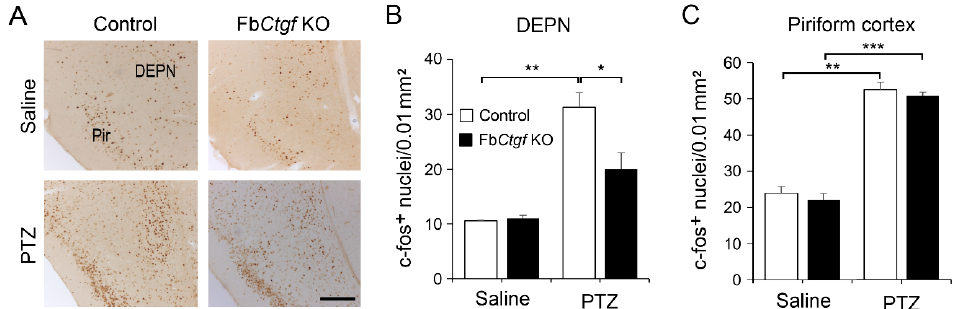
Figure 4. The expression of c-fos in the dorsal endopiriform nucleus (DEPN) and piriform (Pir) cortex was revealed using immunohistochemistry ( A ). The densities of c-fos-positive nuclei in saline- and PTZ (50 mg / kg)-treated mice were quantified ( B , C ). For saline group, n = 3 per genotype; for PTZ group, n = 5 per genotype. Results are mean ± SEM. Asterisks indicate significant di ff erences (* p < 0.05; ** p < 0.01; *** p < 0.001). Bar = 200 µ